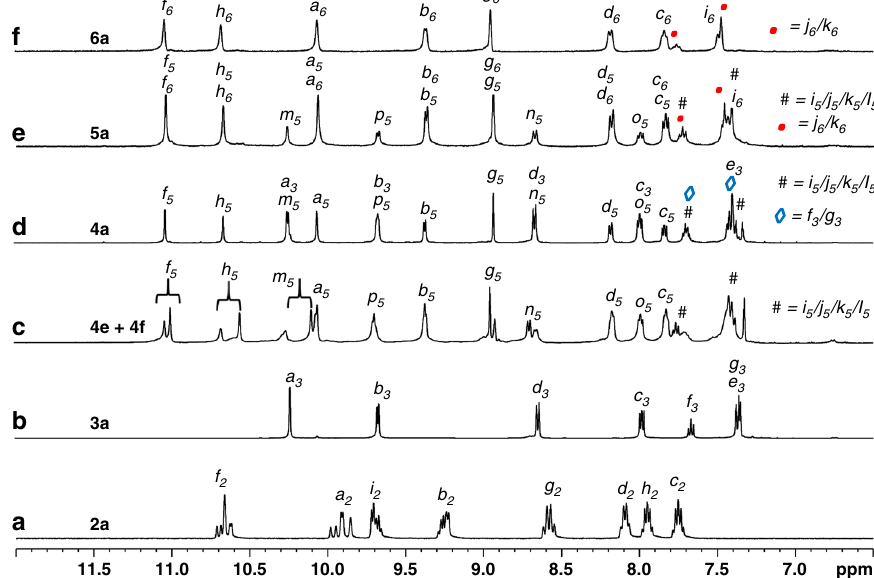
Fig. 4 Characterization of the complexes 2a − 6a and 4e/4f. Partial 1 H NMR spectra (400 MHz, DMSO- d 6 , 300 K) of a cage 2a (diastereomeric mixture), b cage 3a (trinuclear), c mixture of 4e and 4f (tri- and hexanuclear), d cage 4a (tetranuclear), e cage 5a (pentanuclear), and f cage 6a (hexanuclear).